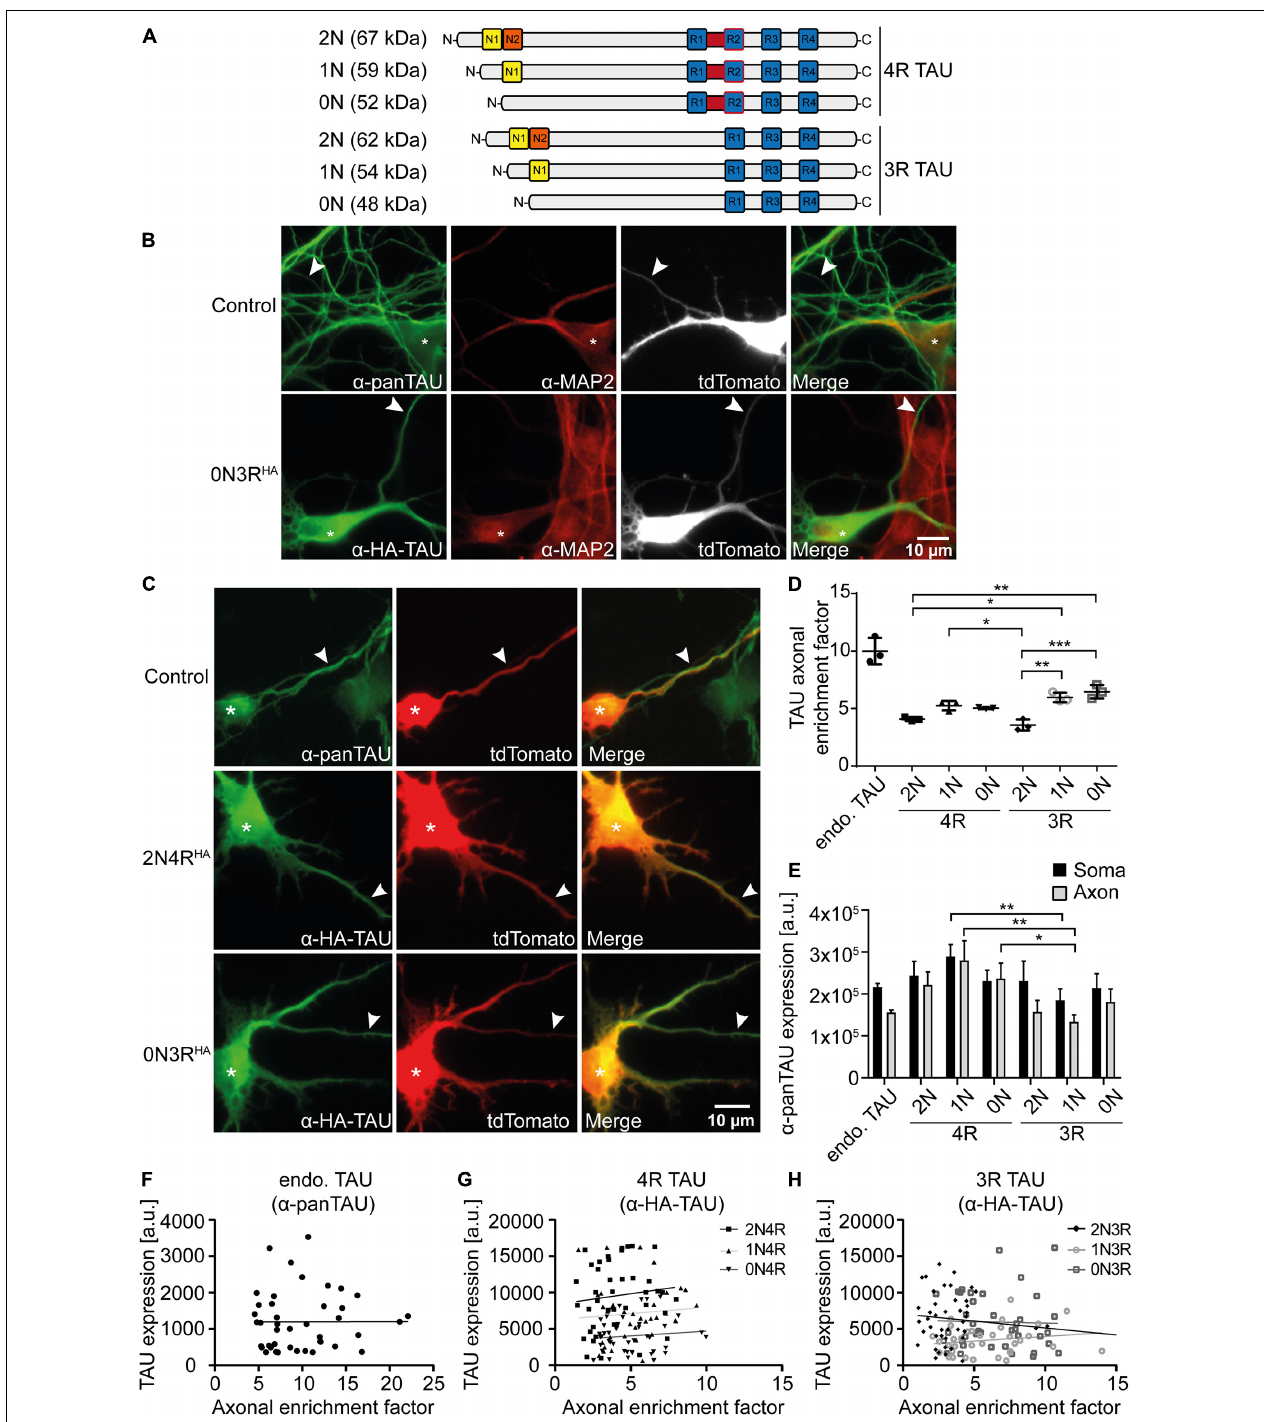
FIGURE 1 | 2N-containing TAU HA isoforms are less efficiently sorted into the axon in mouse primary neurons. HA-tagged TAU isoforms (0N, 1N, 2N, and 3R or 4R) and tdTomato as a volume marker were co-transfected into mouse primary neurons (DIV4) and expressed for two days. (A) Schematic overview of the six TAU isoforms expressed in human brains and their estimated sizes in kDa. N1, N2 = N-terminal inserts; R1–R4 = C-terminal repeat domains. (B) Representative images of mouse primary neurons (DIV6) transfected with tdTomato (Ctrl.) or co-transfected with tdTomato and 0N3R-TAU, respectively. Neurons were stained with α -pan-TAU (for endogenous TAU in control) or α -HA antibody (for transfected TAU HA ) and α -MAP2 to distinguish axons and dendrites. Arrowheads indicate axons, asterisks indicate cell bodies. (C) Representative images of mouse primary neurons (DIV6) transfected with tdTomato (Ctrl.) or co-transfected with tdTomato and 2N4R-TAU HA and 0N3R-TAU HA , respectively. Neurons were stained with α -Tau (for control) or α -HA antibody to analyze axonal enrichment of transfected or